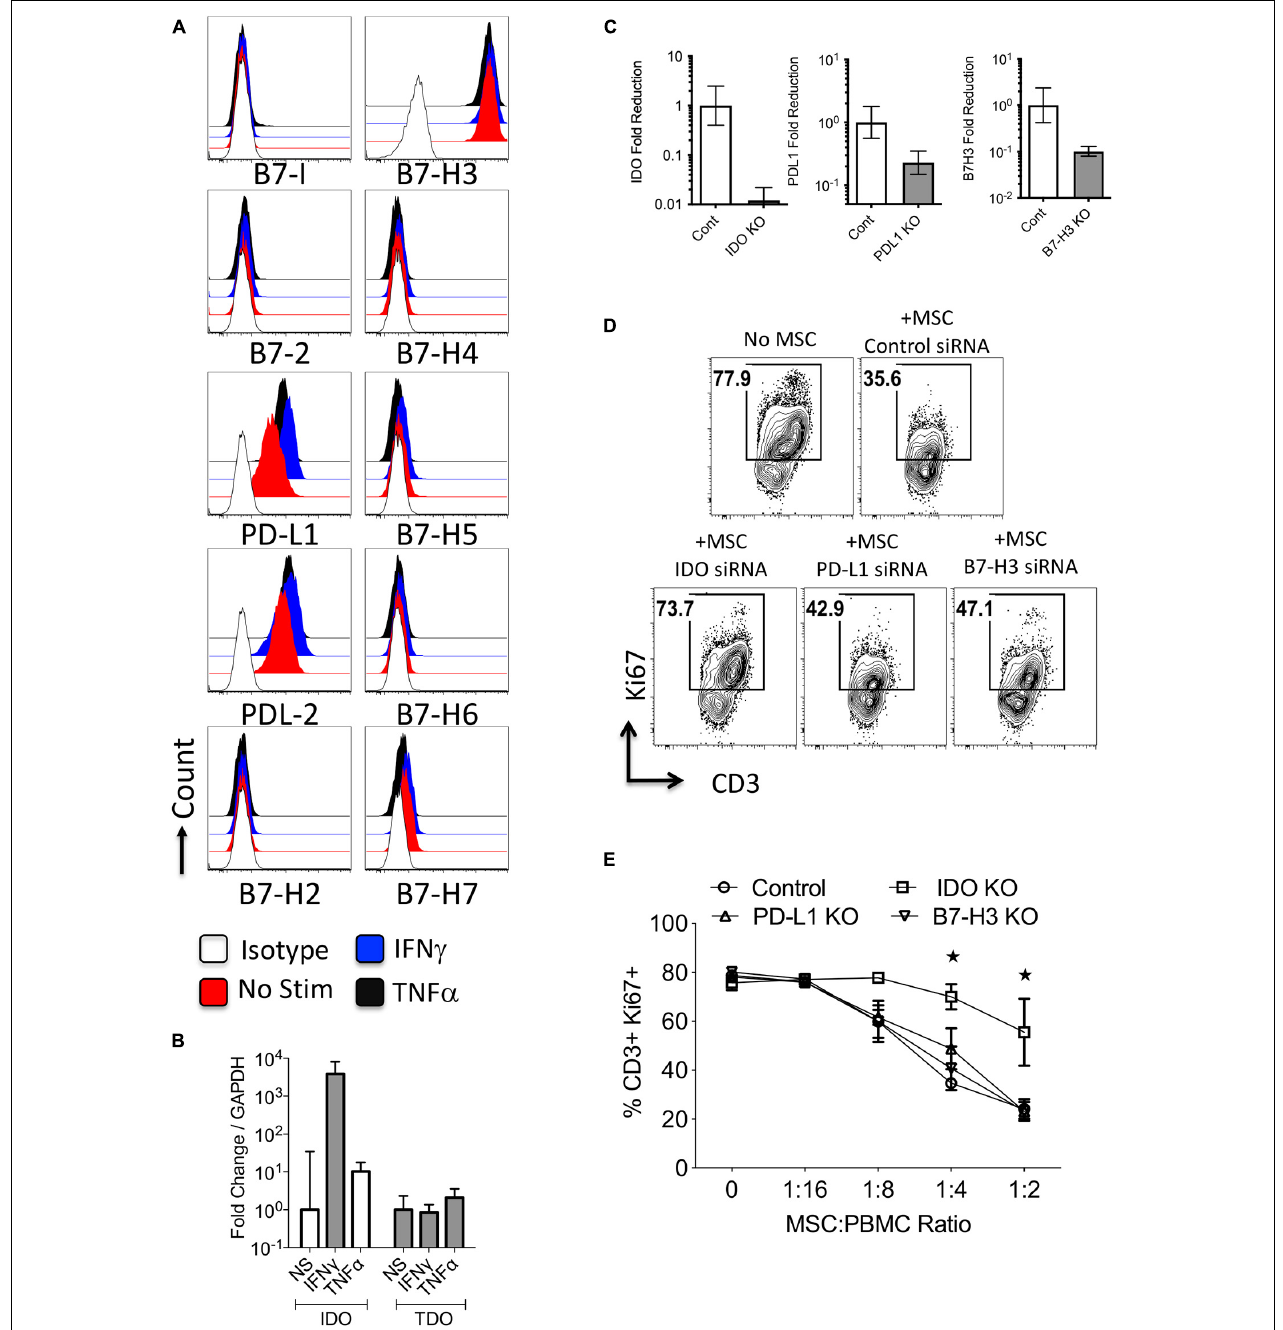
FIGURE 3 | Regulation and functions of B7 family ligands and tryptophan degrading enzymes in Mesenchymal stromal cells. (A) Bone marrow derived MSCs were stimulated with IFN γ and TNF α and surface expressions of B7 family ligands were analyzed through flow cytometry. Histogram analysis shows the expressions of B7 family ligands on MSCs in response to IFN γ and TNF α . Appropriate isotype controls are included. (B) Bone Marrow derived MSCs were stimulated with IFN γ and TNF α for 48 h. The RNA was extracted from the cells and the expression levels of IDO and TDO mRNA was quantitated by the quantitative SYBR green real time PCR. GAPDH mRNA levels were used as internal controls. Delta-delta CT method was applied to calculate the fold change. (C) Control or IDO or PD-L1 or B7-H3 siRNA transfected MSCs were stimulated with IFN γ for 48–72 h. Expression level of IDO, PD-L1, and B7-H3 mRNA relative to GAPDH was evaluated by quantitative SYBR green real time PCR. Delta-delta CT method was applied to calculate the fold reduction. (D) IDO or PD-L1 or B7-H3 or control siRNA transfected MSCs were cultured with SEB stimulated PBMCs. After 4 days, T-cell proliferation was measured by Ki67 intracellular staining. (D) Representative FACS Plot and (E) dose dependent effect of MSCs on T cell proliferation is shown. Two-way analysis of variance (ANOVA) multiple-comparison test was performed between the independent conditions. * P ≤ 0.05. Mean and standard deviation are shown from technical replicates. Representative results are shown from two independent experiments.